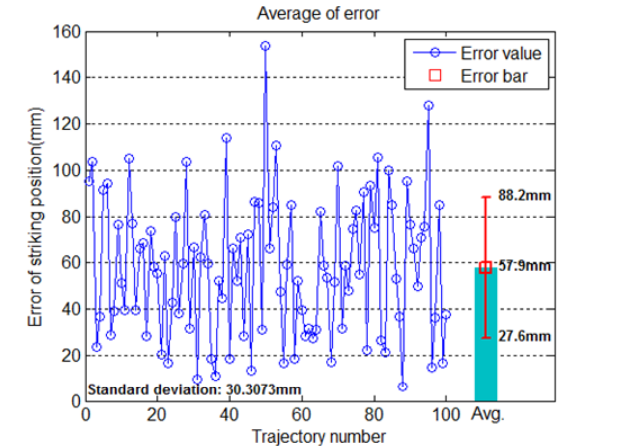
Figure 18. Striking position error of the physical